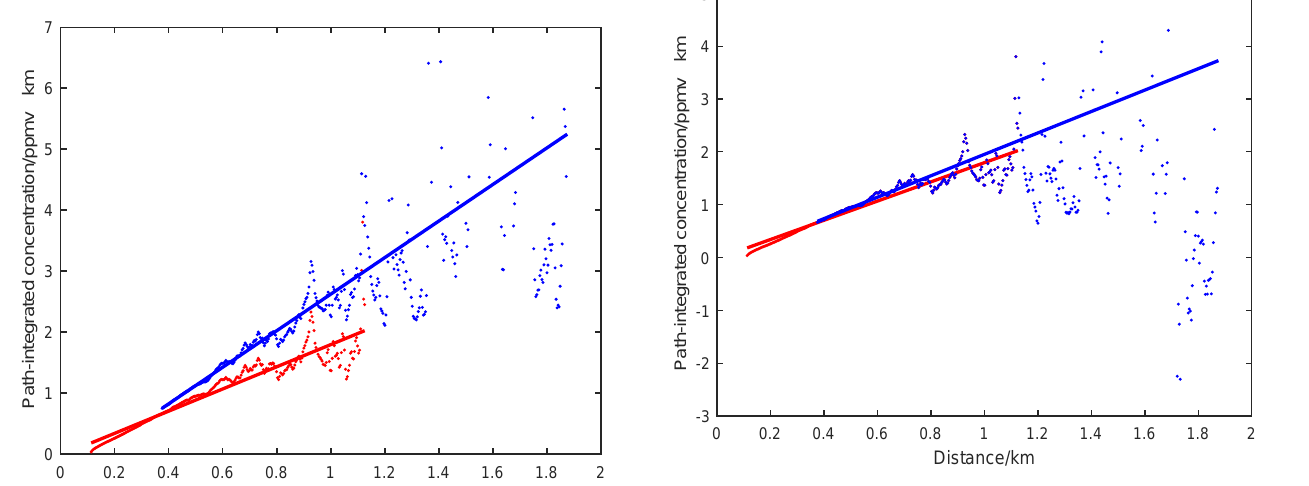
Figure 11. As Fig. 9 but with the values of α and β fixed to be α 0 and β 0 in the GLS